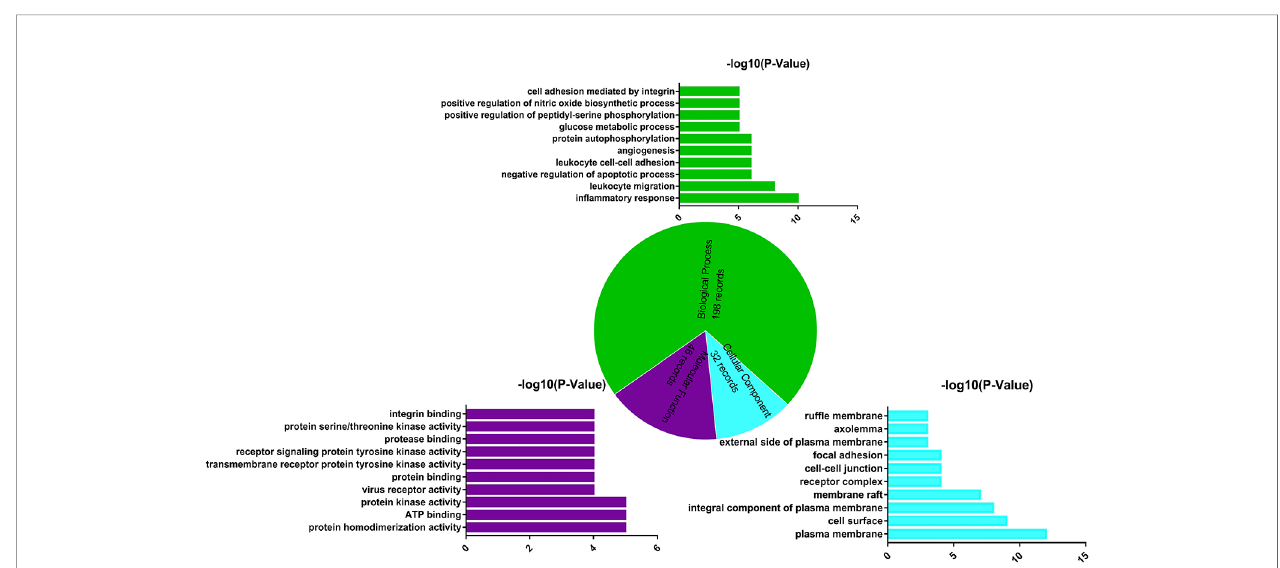
FIGURE 4 | Gene Ontology (GO) enrichment analysis of the target proteins. Biological process (green), molecular function (purple), and cellular component (blue) accounted for 71.47%, 16.67%, and 11.59%,